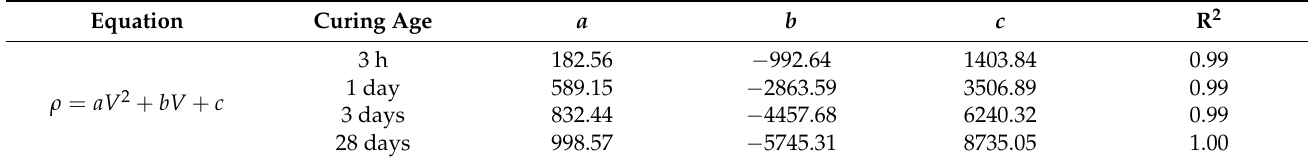
Table 4. The fitting results of the relationship between ρ and V .